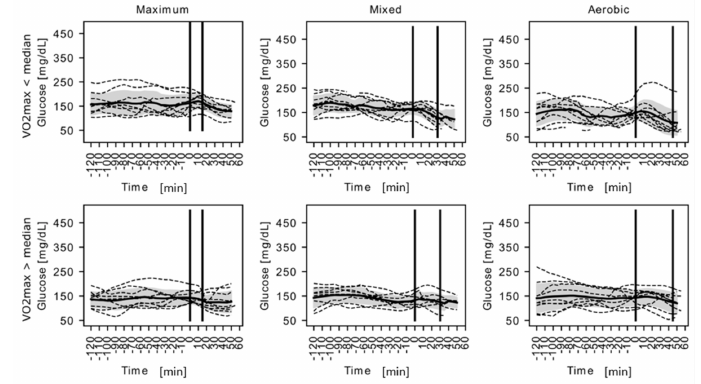
Figure 1. CGM traces for all study participants during each test